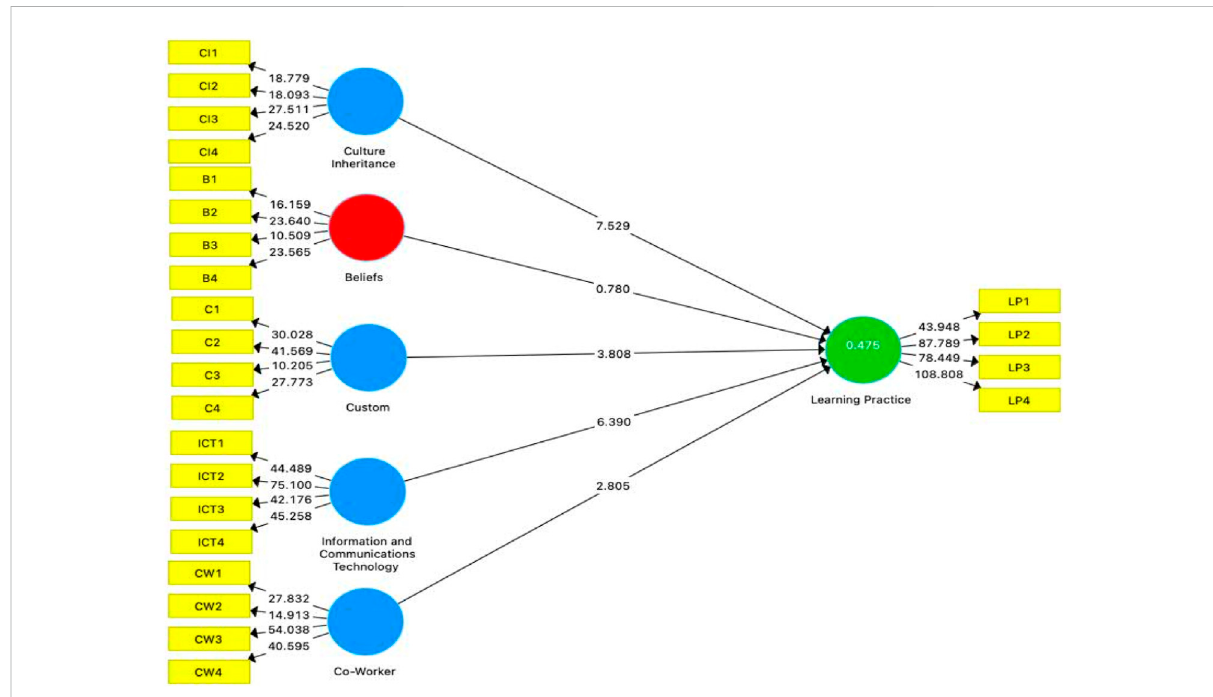
FIGURE 2 Measurement model, (Green and blue variables = Signi fi cant; Green and red variables = Insigni fi